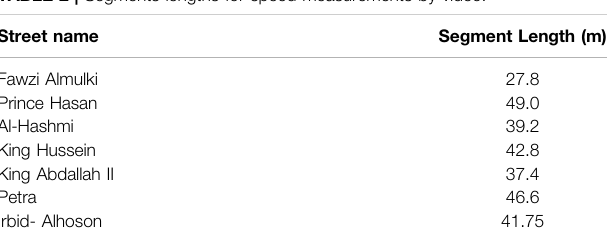
TABLE 2 | Segments lengths for speed measurements by video.